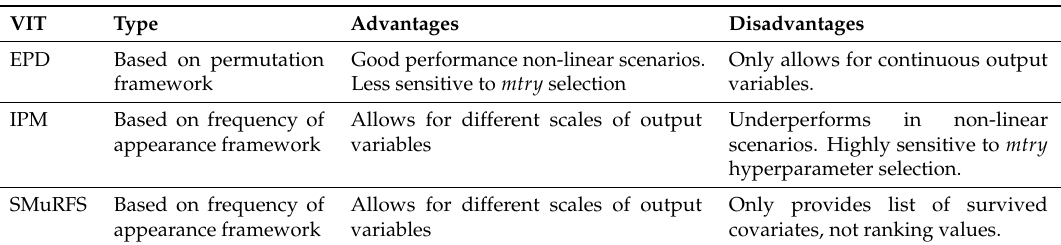
Table 1. Comparison: tree-based variable importance techniques (VIT) for multi-output